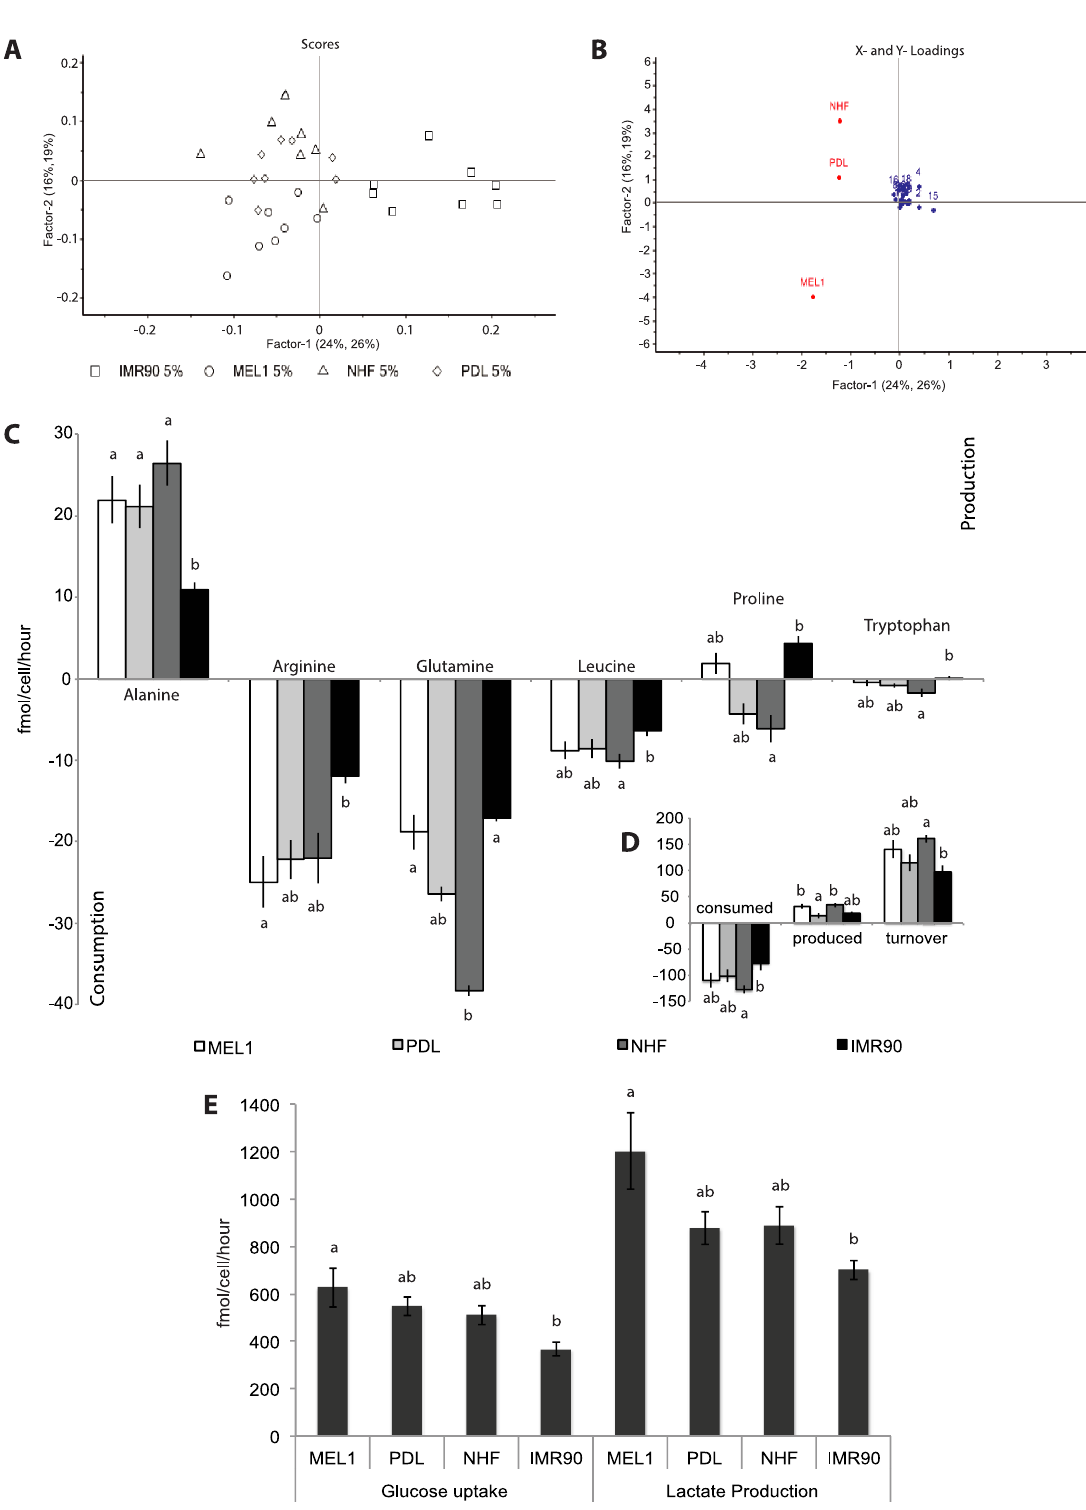
Fig 2. Comparison of metabolite use by cell lines cultured under 5% oxygen conditions. ( A ) PLSDA scores plot of amino acid concentrations of human ES and iPS cells cultured in mTeSR medium under 5% oxygen. ( B ) PLSDA loadings plot of amino acid concentrations of human embryonic and iPS cells cultured in mTeSR medium under 5% oxygen. ( C ) Significant differences in amino acid utilisation, ( D ) total amino acid consumption, production and turnover, and ( E ) glucose uptake and lactate production between MEL1 human